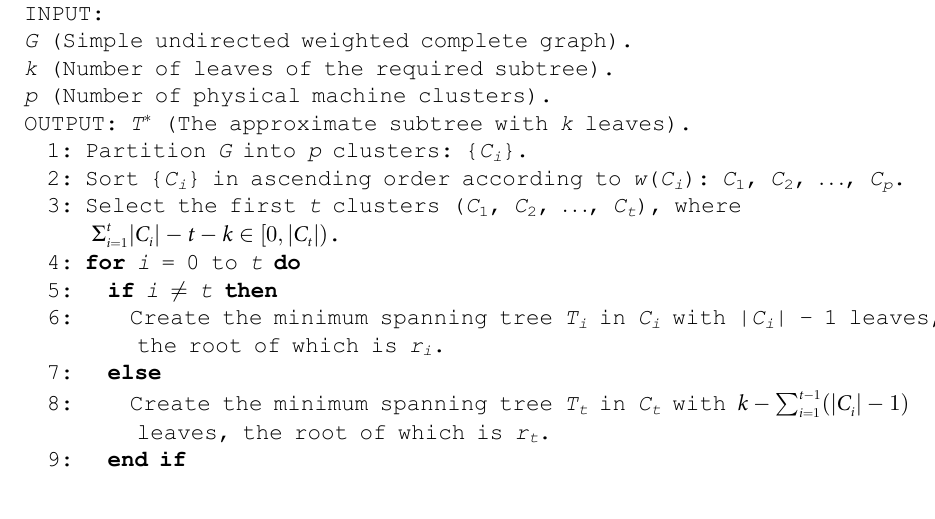
Algorithm 1 Cluster-and-Union